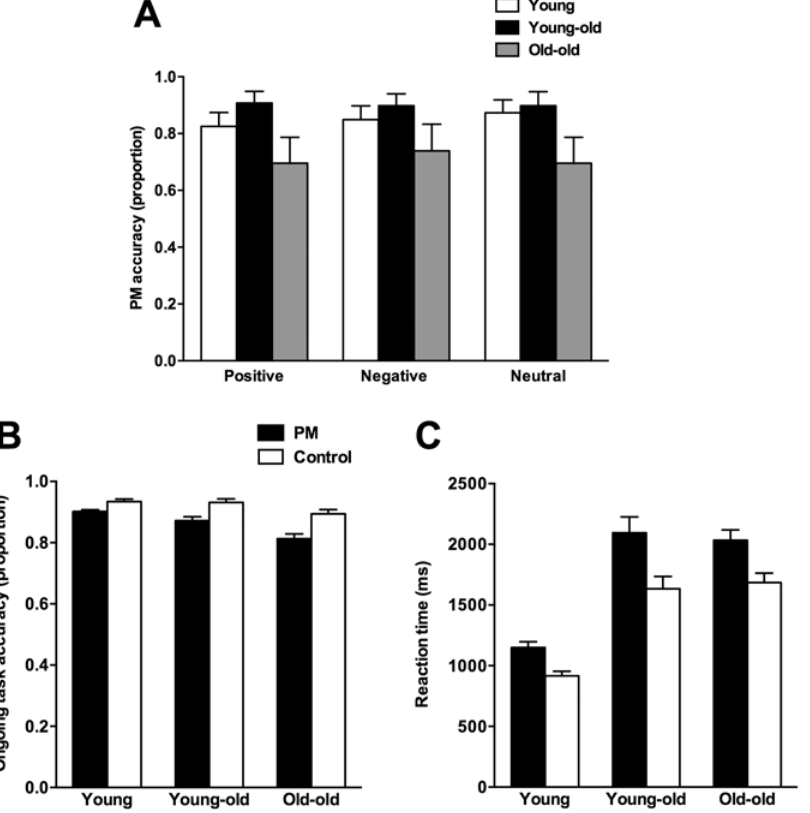
Fig 1. Prospective memory accuracy as a function of emotional valence (Fig 1a); ongoing task accuracy (Fig 1b) and reaction time (Fig 1c) as a function of ongoing task phase (PM, no PM). Bars represent one standard error of the